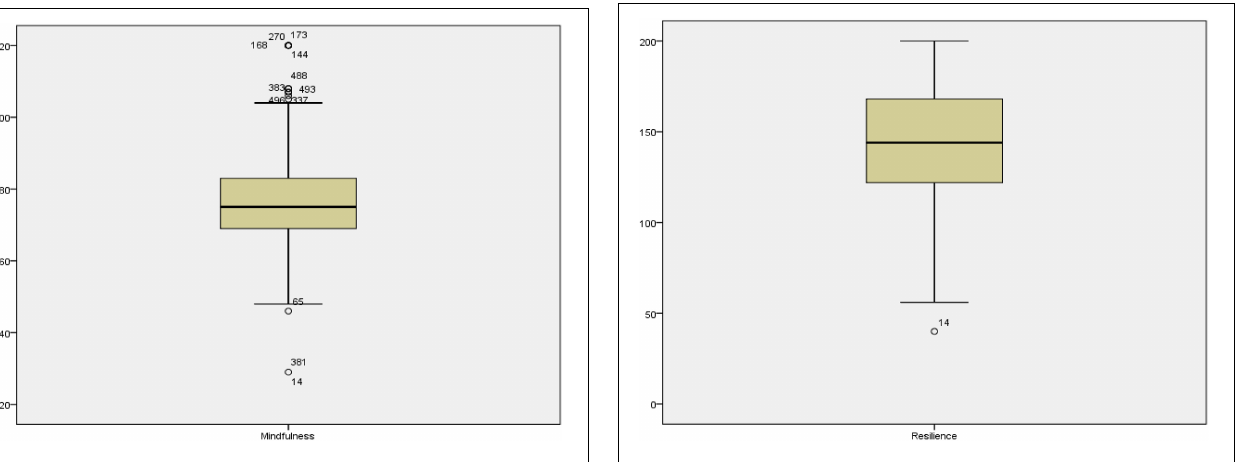
FIGURE 1 | The boxplot for mindfulness. FIGURE 2 | The boxplot for